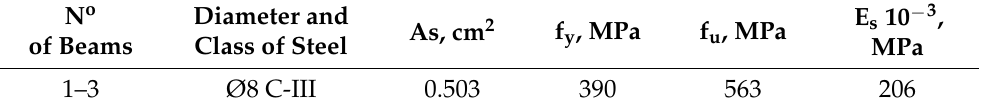
Table 5. Strength and deformative characteristics of steel in experimental beams.